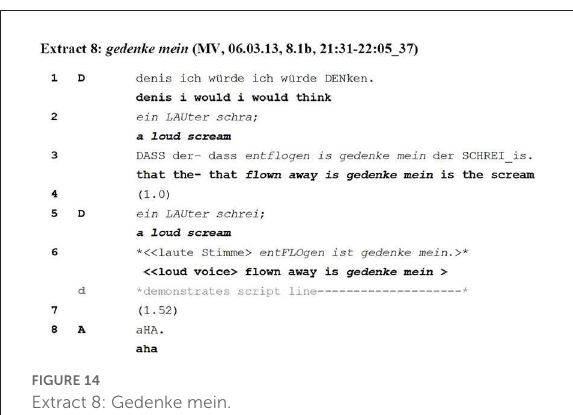
FIGURE14 Extract 8: Gedenke mein.